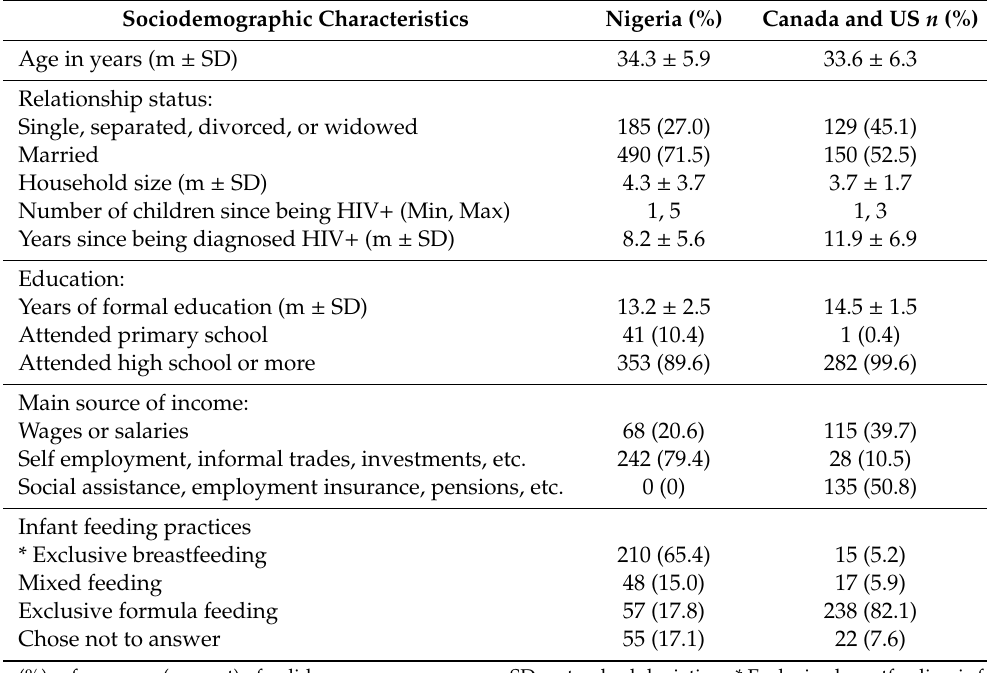
Table 1. Sociodemographic characteristics of the study